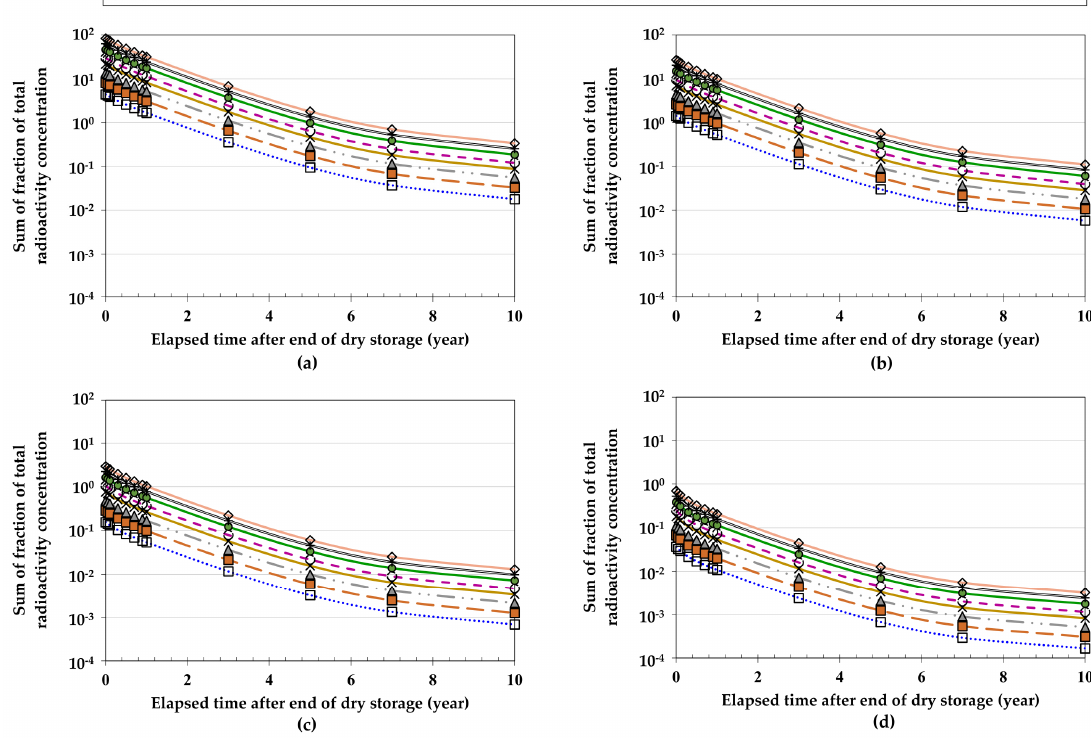
Figure 8. Sum of fractions of the estimated radioactivity concentration to the clearance level of each radionuclide for each MPC-24 component: ( a ) basket, ( b ) shell, ( c ) baseplate, and ( d ) lid.